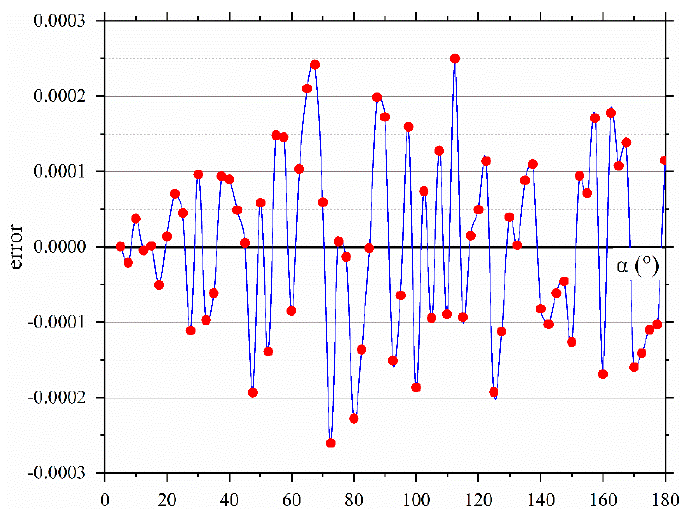
Figure 4. The error curve calculated by MATLAB.